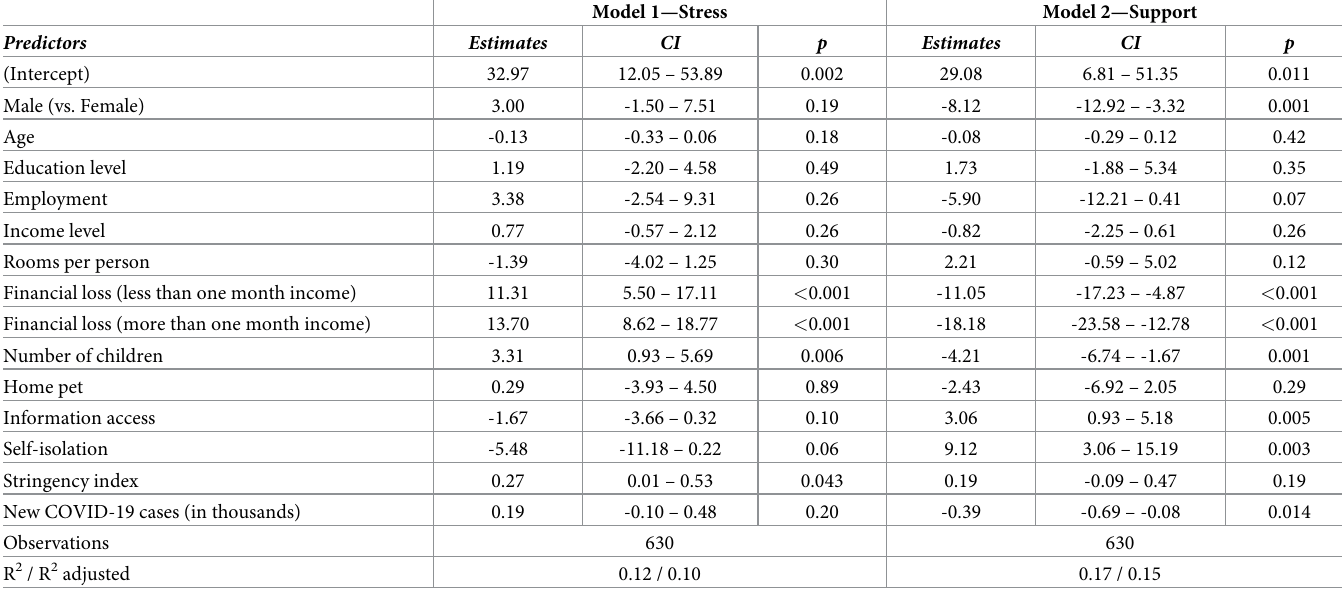
Table 2. Regression coefficients for Model 1 and Model 2.